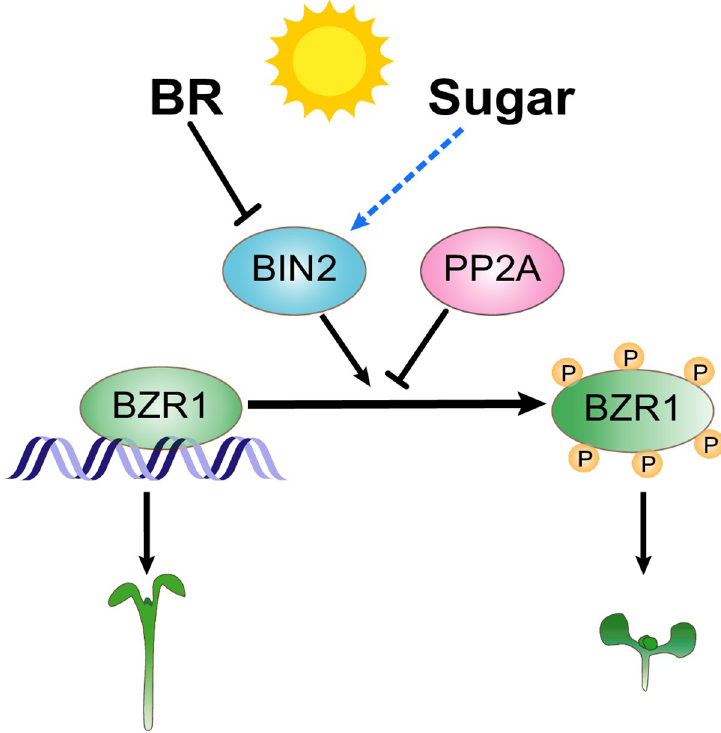
Fig 5. A model of sugar suppressing BR signaling to modify plant growth in light. In light, BR signaling inhibits BIN2 activity, which induces accumulation of active BZR1 to promote plant growth, whereas sugar induces the phosphorylation of BZR1 to suppress BR signaling probably through increasing BIN2 activity by unknown sugar signaling pathway. The black bars and arrows indicate previously reported mechanisms; the blue arrow indicates findings made in this